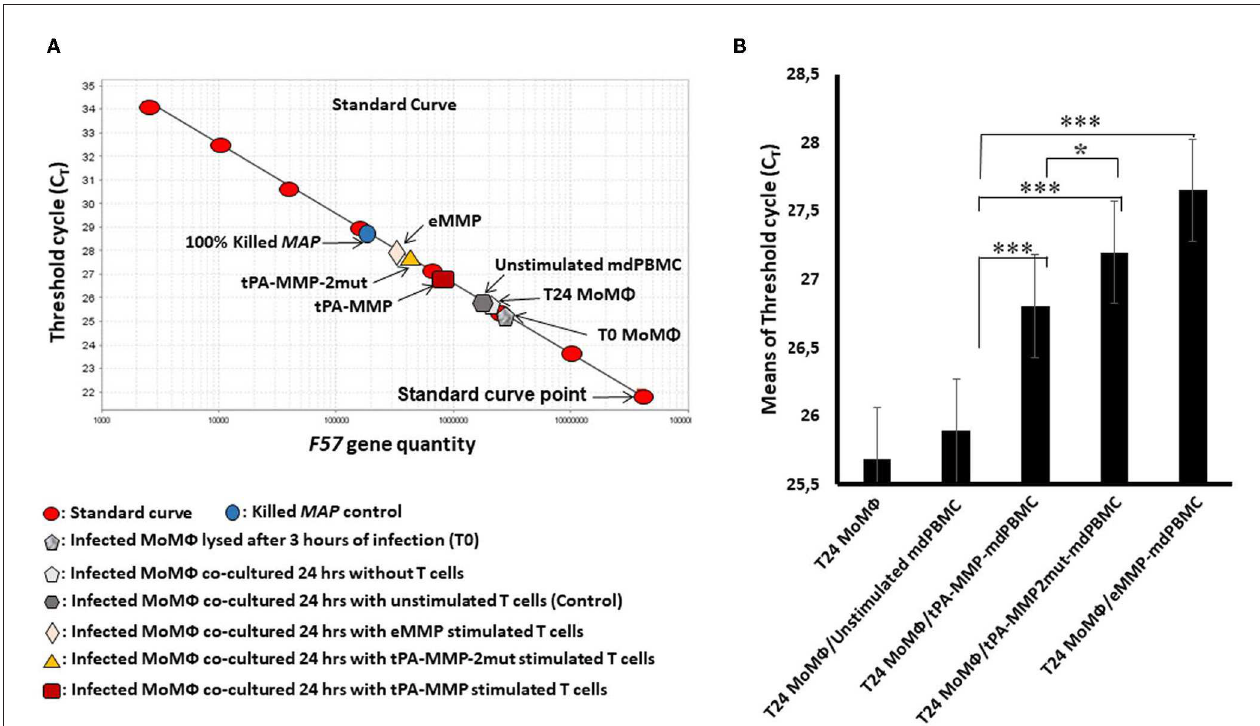
FIGURE 7 | Intracellular Map PMA-QPCR viability assay. (A) Graphical representation of real-time PCR data for Map intracellular killing to determine the C T values measured for amplification of the Map F57 target gene. C T values represent average of duplicate preparations of DNA isolated from pure Map (8 red oval points), Map viability control (blue circle), Map -infected MoM 8 lysed after 3h of infection (gray pentagon), Map -infected MoM 8 lysed after 24h of infection (light gray pentagon), cell mixture lysed after 24h of co-culturing of Map -infected MoM 8 with unstimulated mdPBMC (dark gray hexagon), cell mixture lysed after 24-h co-culture of Map -infected MoM 8 with mdPBMC stimulated twice with tPA-MMP (dark red rectangle), tPA-MMP-5mut (gold triangle), or eMMP (pink diamond). (B) Summary of three biological replicate experiments performed in duplicate from each of the three steers comparing the killing activity following stimulation with the different MMP peptides relative to controls. * P < 0.05; *** P <